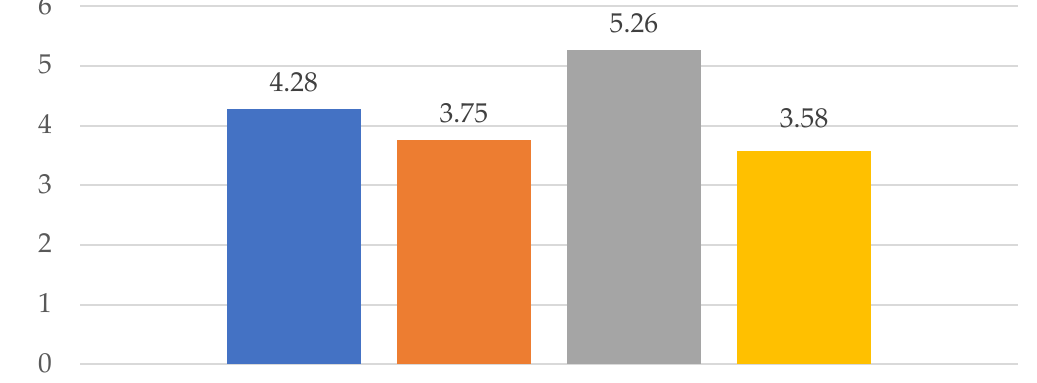
Figure 7. Average student perception of specific product characteristics during the purchase process.